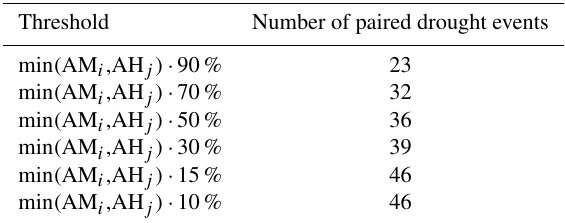
Table 1. Sensitivity test of parameter b